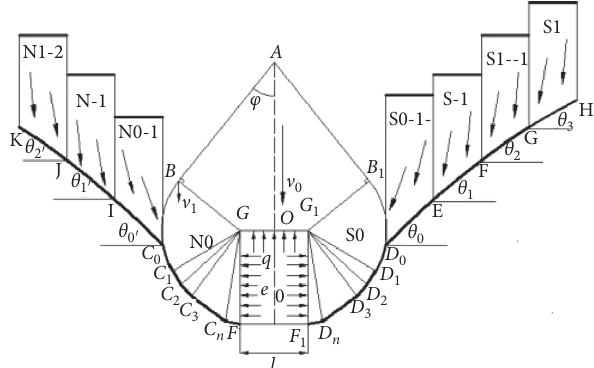
Figure 5: Deformation mechanism of mining schematic collapse.